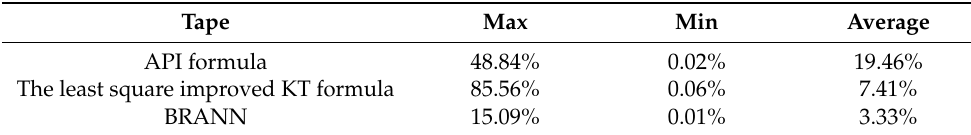
Table 5. Output error of blind test